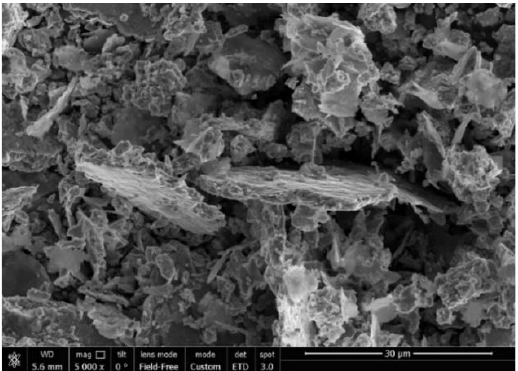
Figure 1. The SEM-photo of the Al – CuO mixture after mechanical activation.